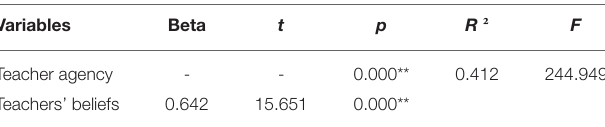
TABLE 3 | Correlations of the